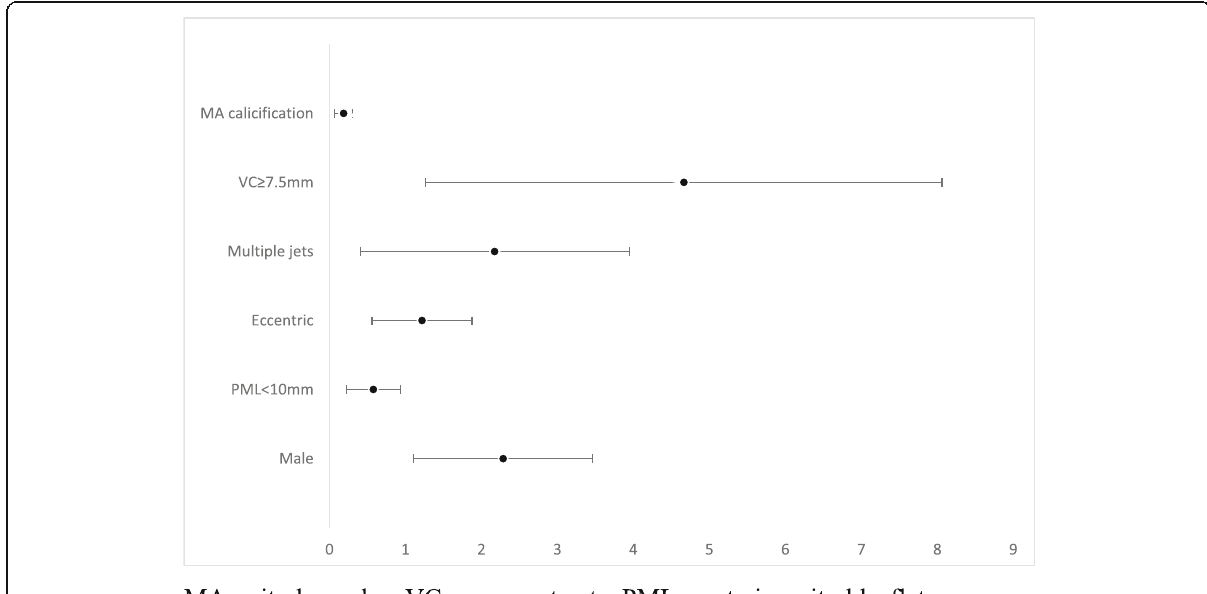
Fig. 2 Odds ratios of the possible predictors of the use of multiple clips. MA, mitral annulus; VC, vena contracta; PML, posterior mitral leaflet